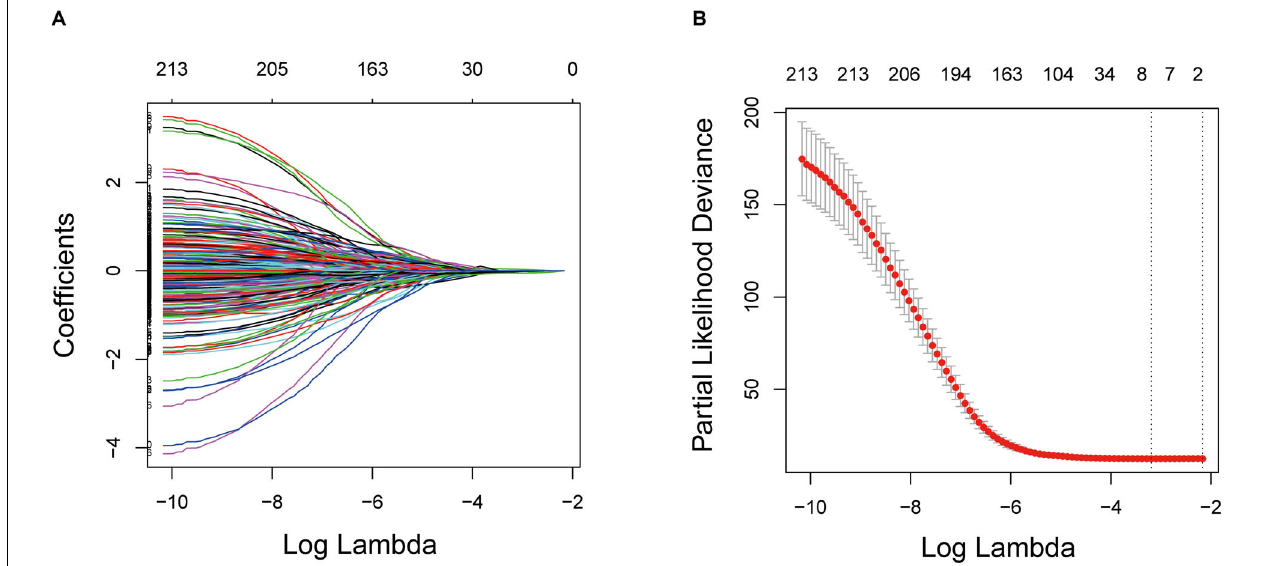
FIGURE 3 | Establishment of prognostic gene signature by LASSO regression analysis. (A) LASSO coefficient profiles of the 214 genes in the training cohort. (B) A coefficient profile plot was generated against the log (lambda) sequence. Selection of the optimal parameter (lambda) in the LASSO model for the training cohort. LASSO: the least absolute shrinkage and selection operator Cox regression model.